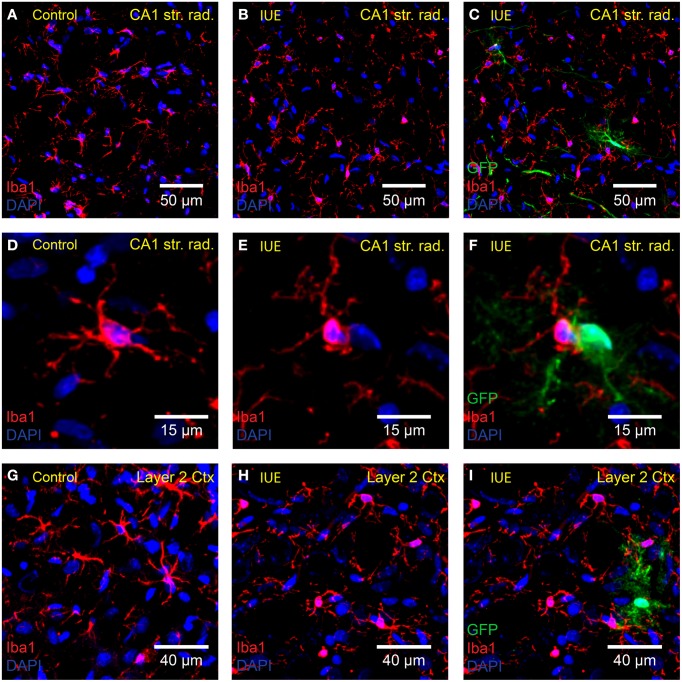
Microglia are not transfected or overtly activated following IUE. Confocal imaging of anti-Iba1 (red) stained microglia in the (A–F) hippocampal CA1 stratum radiatum and (G–I) cortex layer 2 of (A,D,G) unelectroporated brains and (B,C,E,F,H,I) following IUE of CAG-GFP-IRES-Neo. The right-hand column displays images in the middle column overlaid with the green channel (GFP-transfected cells). (C,F,I) As expected, anti-Iba1 did not overlap with GFP. Iba1-positive cells near GFP-transfected cells did not appear to be activated. DAPI staining is shown in blue.